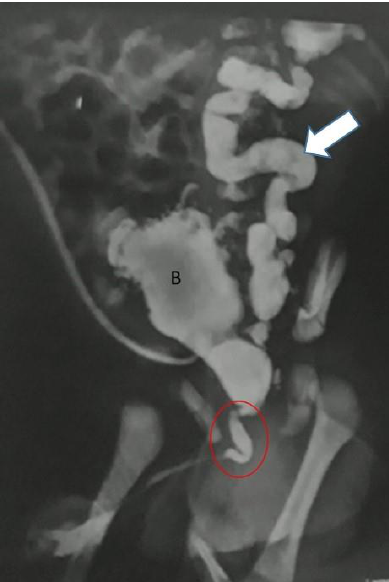
Figure 1: MCUG showing a distended diverticular bladder, a dilated anterior urethra consistent with anterior urethral valve (circle) and left grade V vesicoureteral reflux